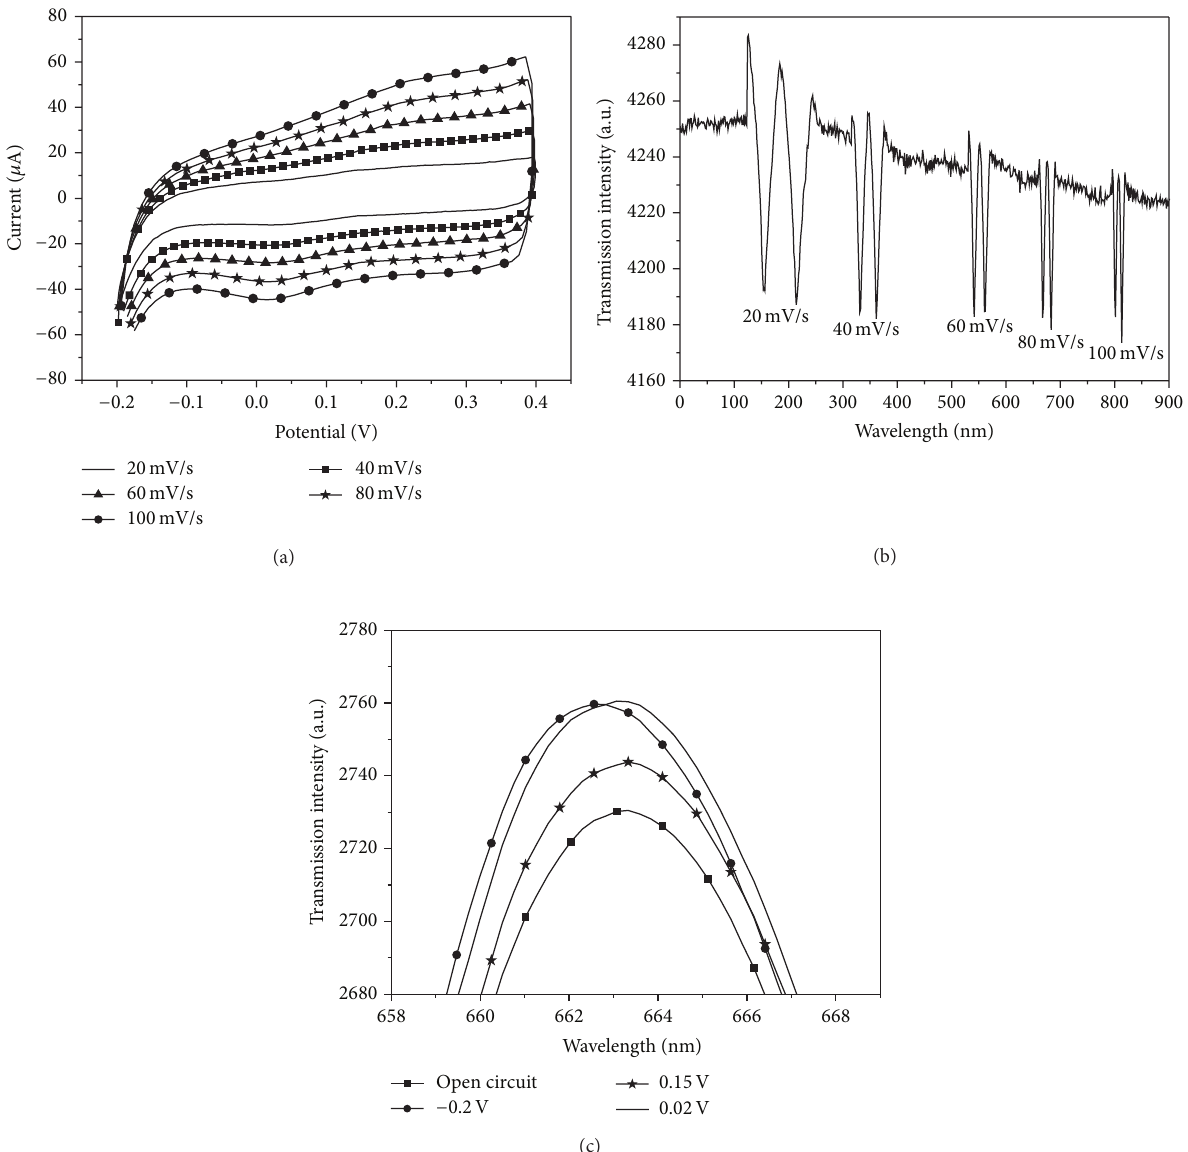
Figure 4: (a) CV traces with (b) corresponding TSPR kinetic curve of PABA film in PBS at various scan rates and (c) TSPR spectra of PABA film during applying constant potentials in PBS for 2 min on BD-R grating